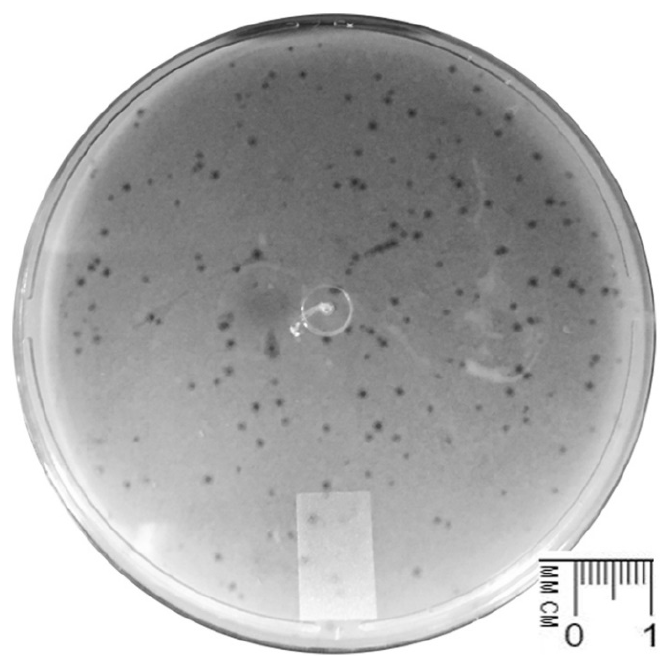
Figure 1. Lysis plaques of phage vB_KpnS_Uniso31 (Kpn31) in a K. pneumoniae CCCD-K001 lawn. Plaques present the same morphology without secondary halos around clear zones of lysis.